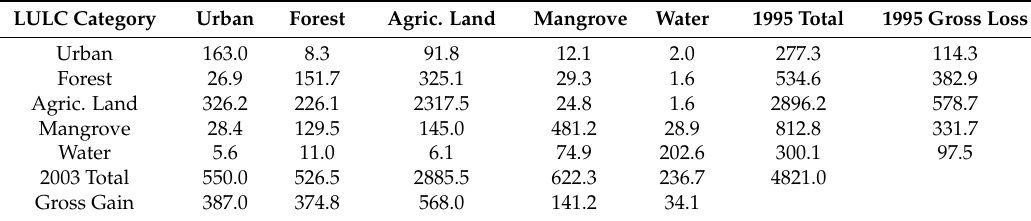
Table 7. Land-cover transition matrix of Greater Port Harcourt watershed area, 1995 to 2003. LULC